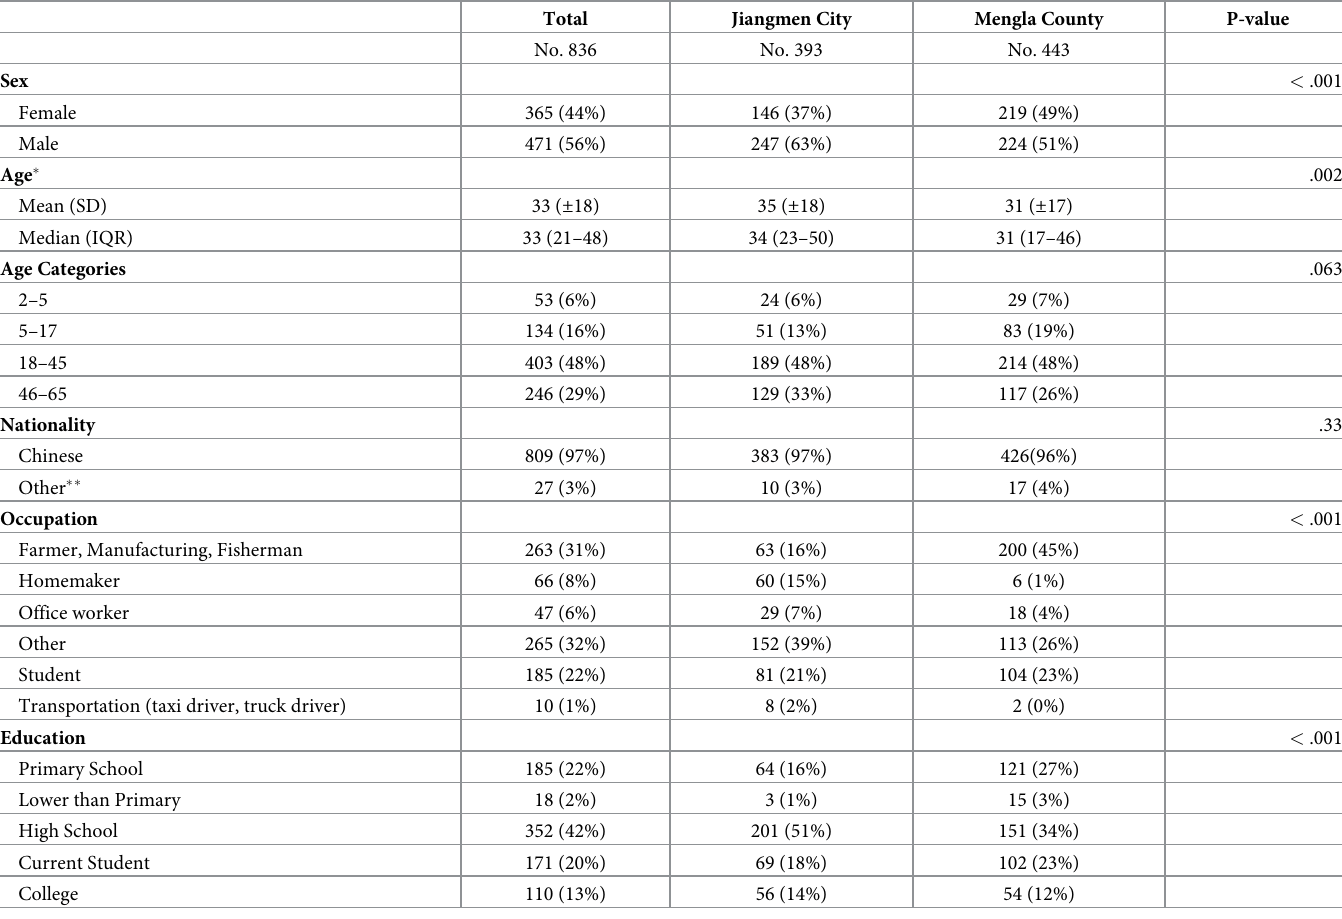
Table 1. Demographic characteristics of patients enrolled in the acute febrile illness surveillance project by location in China, June 2017 –August 2019.